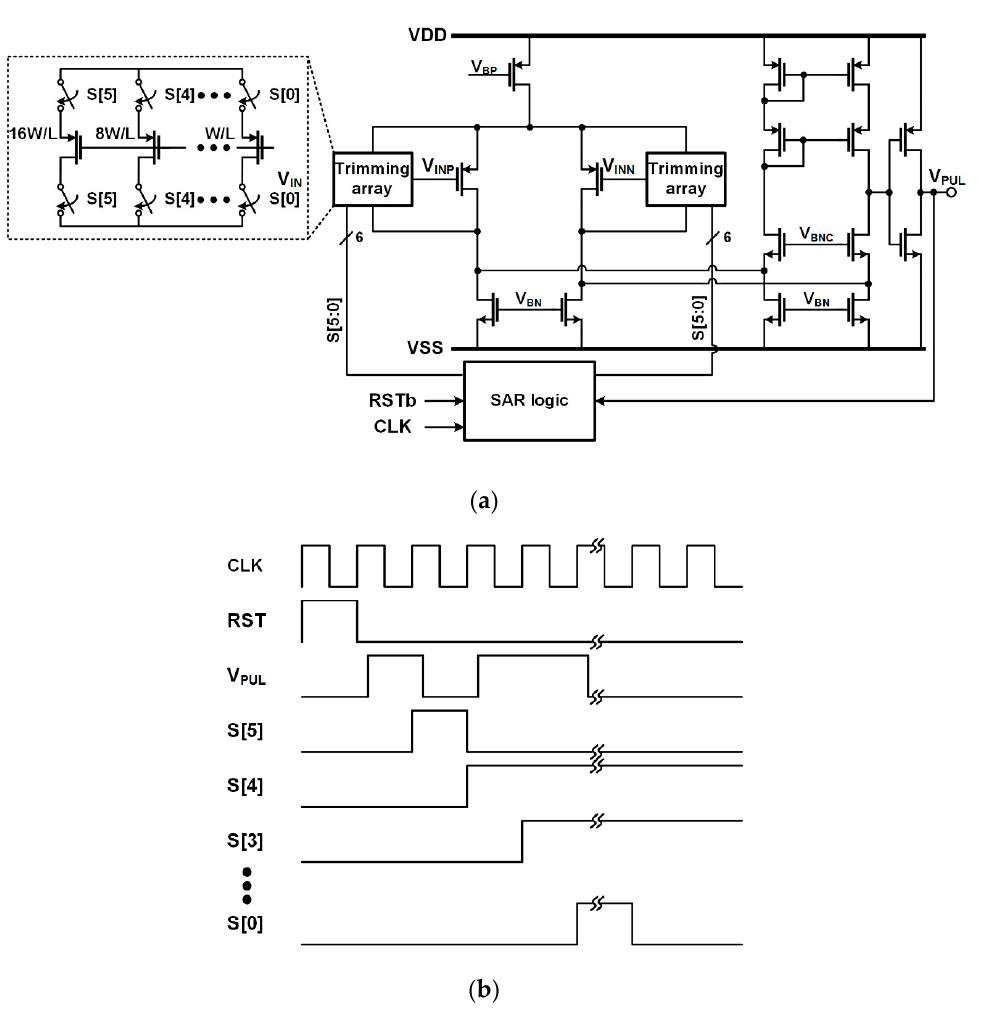
Figure 3. ( a ) Schematic and ( b ) timing diagram of the self-trimmed comparator.